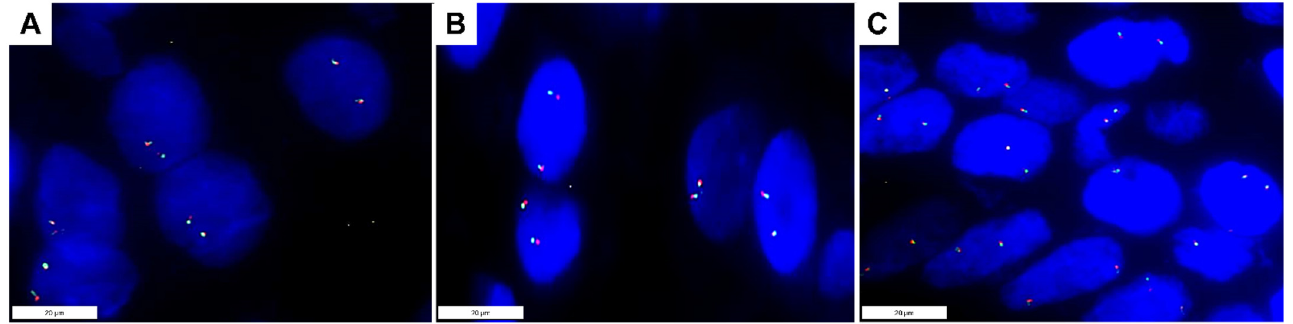
Figure 2. Photomicrographs of break-apart FISH analyses in a Merkel cell carcinoma with positive nuclear pan-TRK immunoreaction showing a wild type signal configuration, namely, the presence of two pairs of closely approximated or fused signals in each nucleus (ZytoLight SPEC NTRK1 ( A ), NTRK2 ( B ), and NTRK3 ( C ) Dual Color Break Apart Probe). Original magnification 1000× ( A – C ).